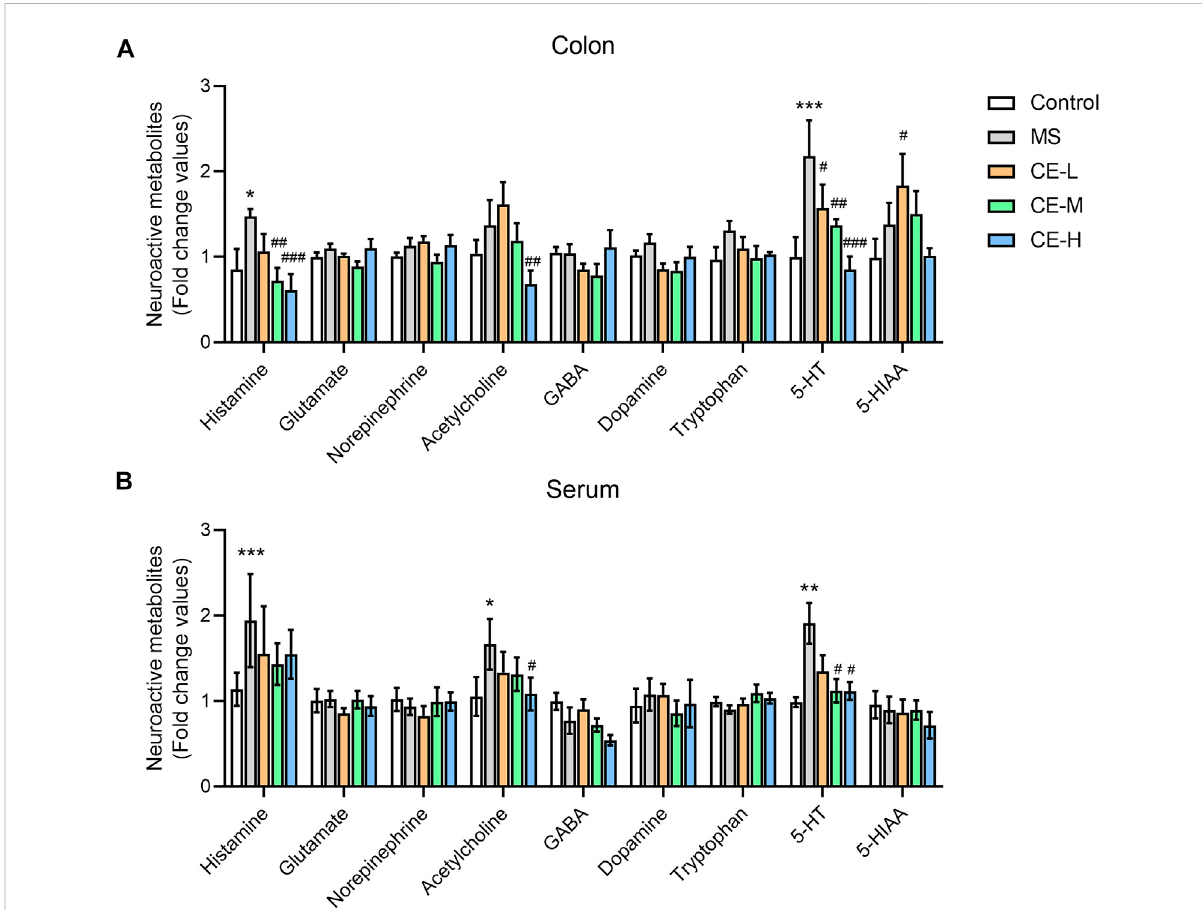
CE decreases circulating and enteric 5-HT bioavailability inMS rats (n = 6 – 8/group). Neuroactive metabolite levels inrat colonic tissues (A) and serum (B) were semi-quanti fi ed using UPLC/TQ-MS. One way ANOVA analysis was used for statistics and signi fi cance was expressed as *, p < .05; **, p < .01; ***, p < .005 compared with the control group; #, p < .05; ##, p < .01; ###, p < .005 compared with the MS model